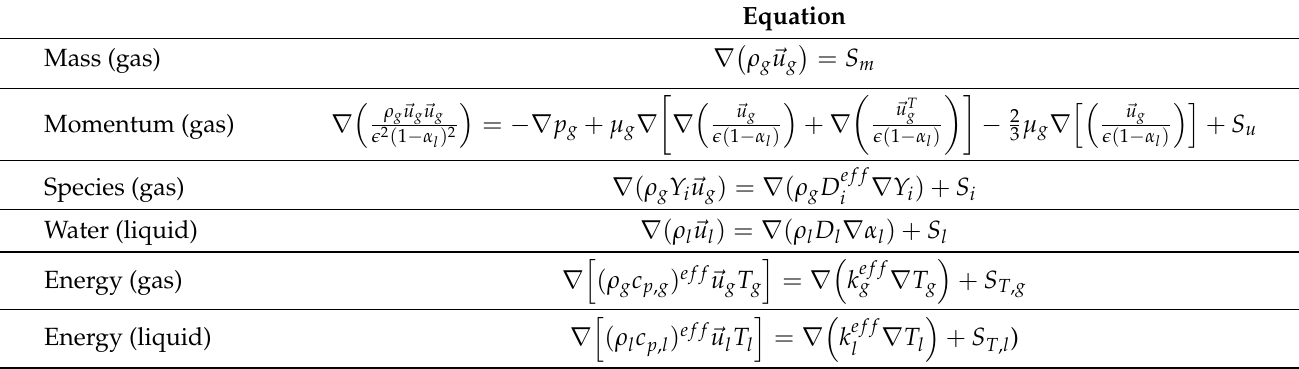
Table 3. Steady-state form of the eulerian multi-phase (EMP) governing equations from the works in [5,24].